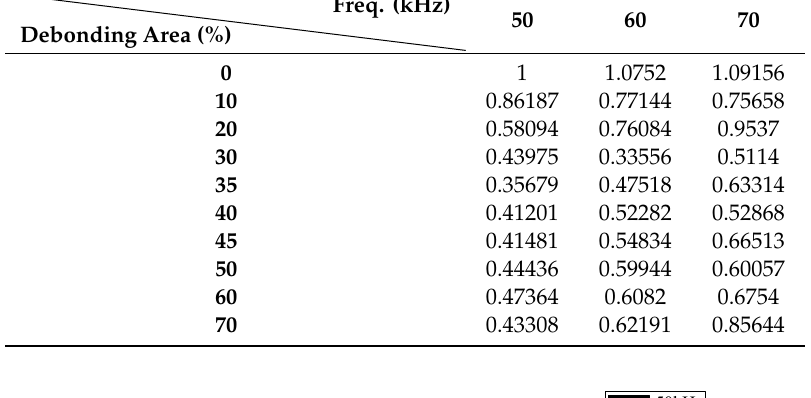
Table 6. The variation of normalized amplitude of the signal when the excitation frequencies is 50 kHz, 60 kHz and 70 kHz. Freq. (kHz) Debonding Area (%)